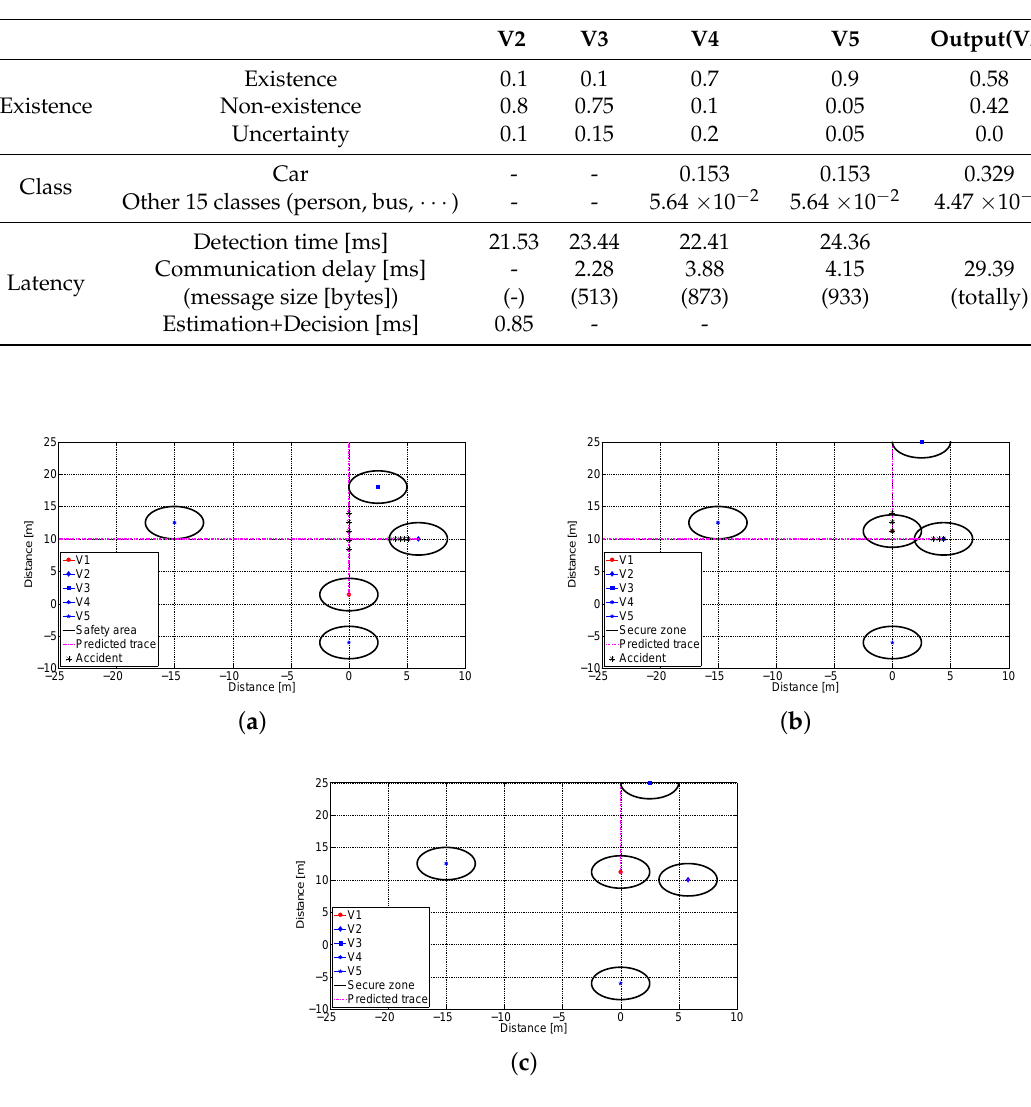
Figure 16. Confidence comparison: ( a ) Changes of the confidences based on the proposed data fusion scheme. ( b ) Changes of the confidences under the weighted data fusion scheme. Table 4. Experimental results for the sensing failover case.